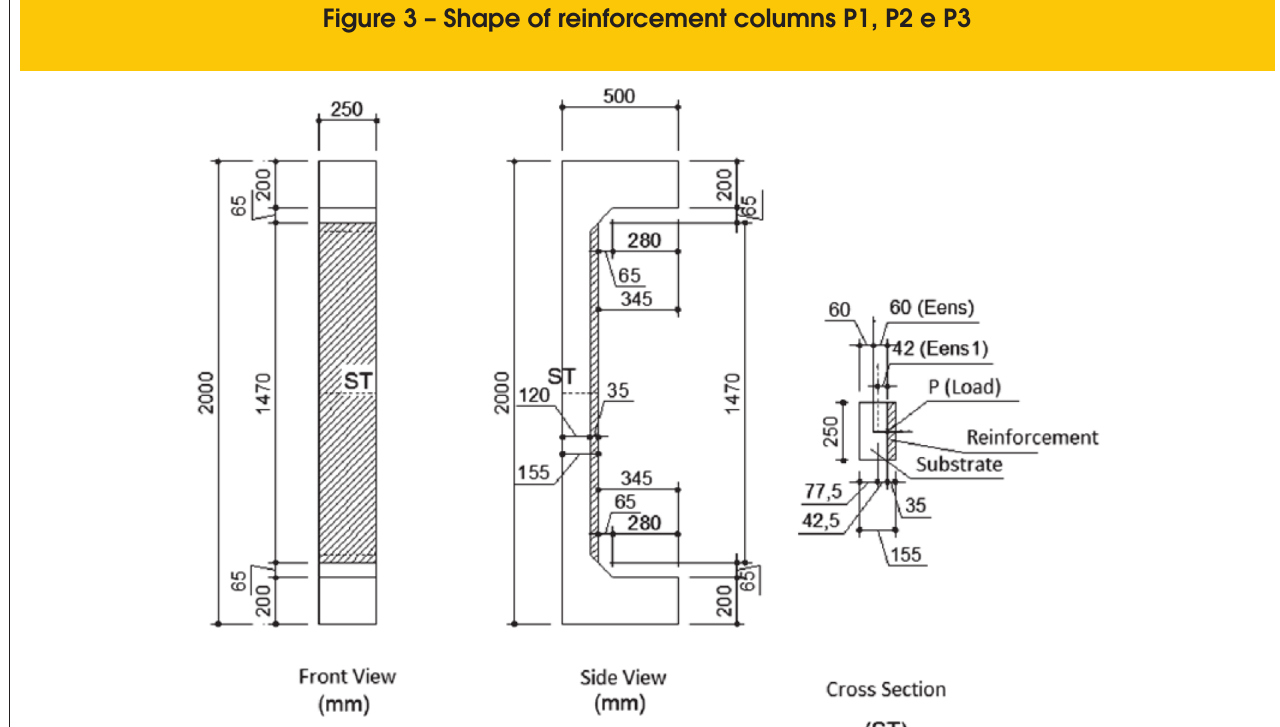
Figure 3 – Shape of reinforcement columns P1, P2 e